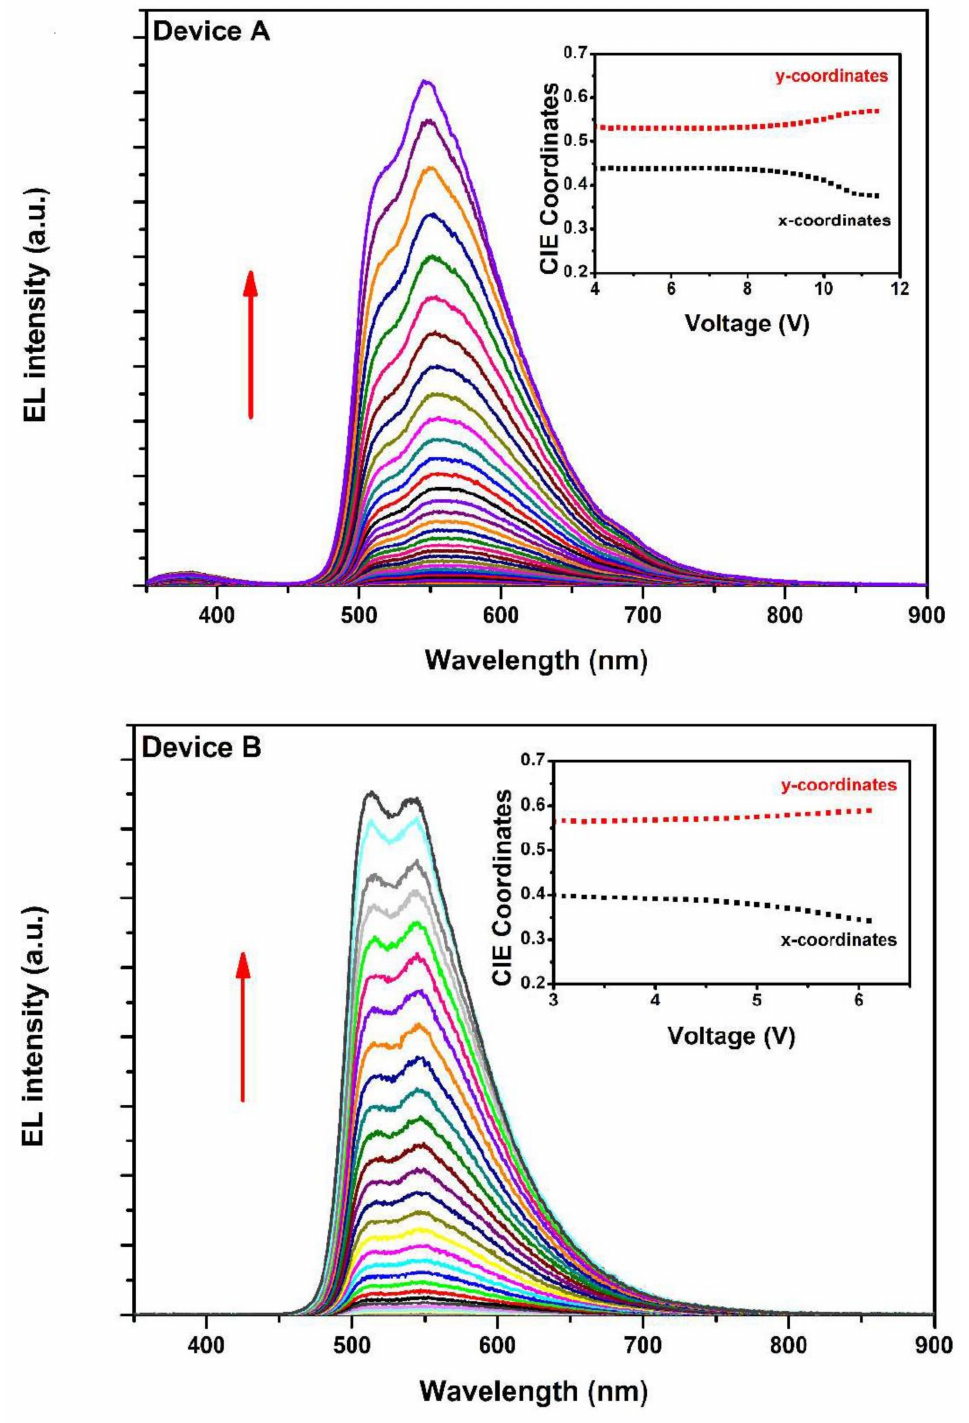
Figure 4. Electroluminescence spectra of OLEDs with device configurations A and B recorded by varying the applied voltage. Inset: variation of the CIE coordinates with the driving